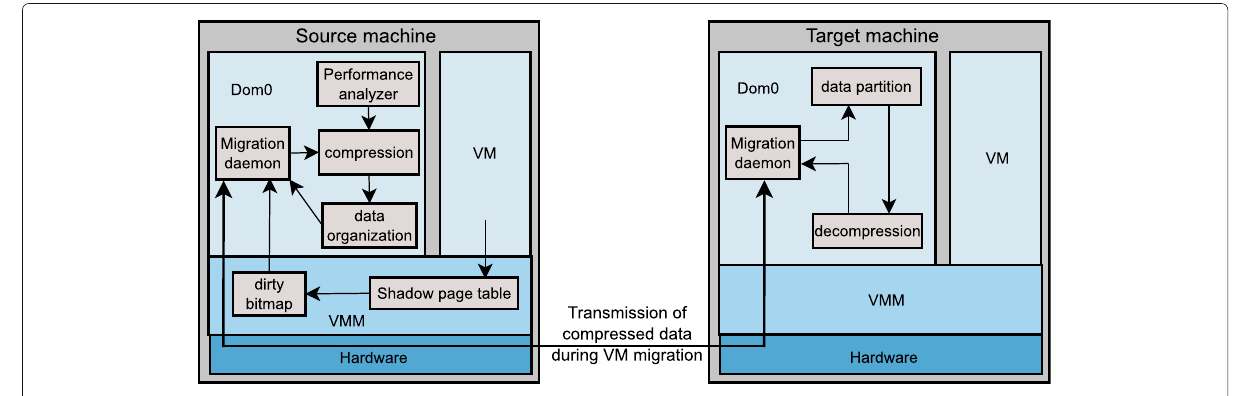
Fig. 8 Generic steps of duplication based VM migration